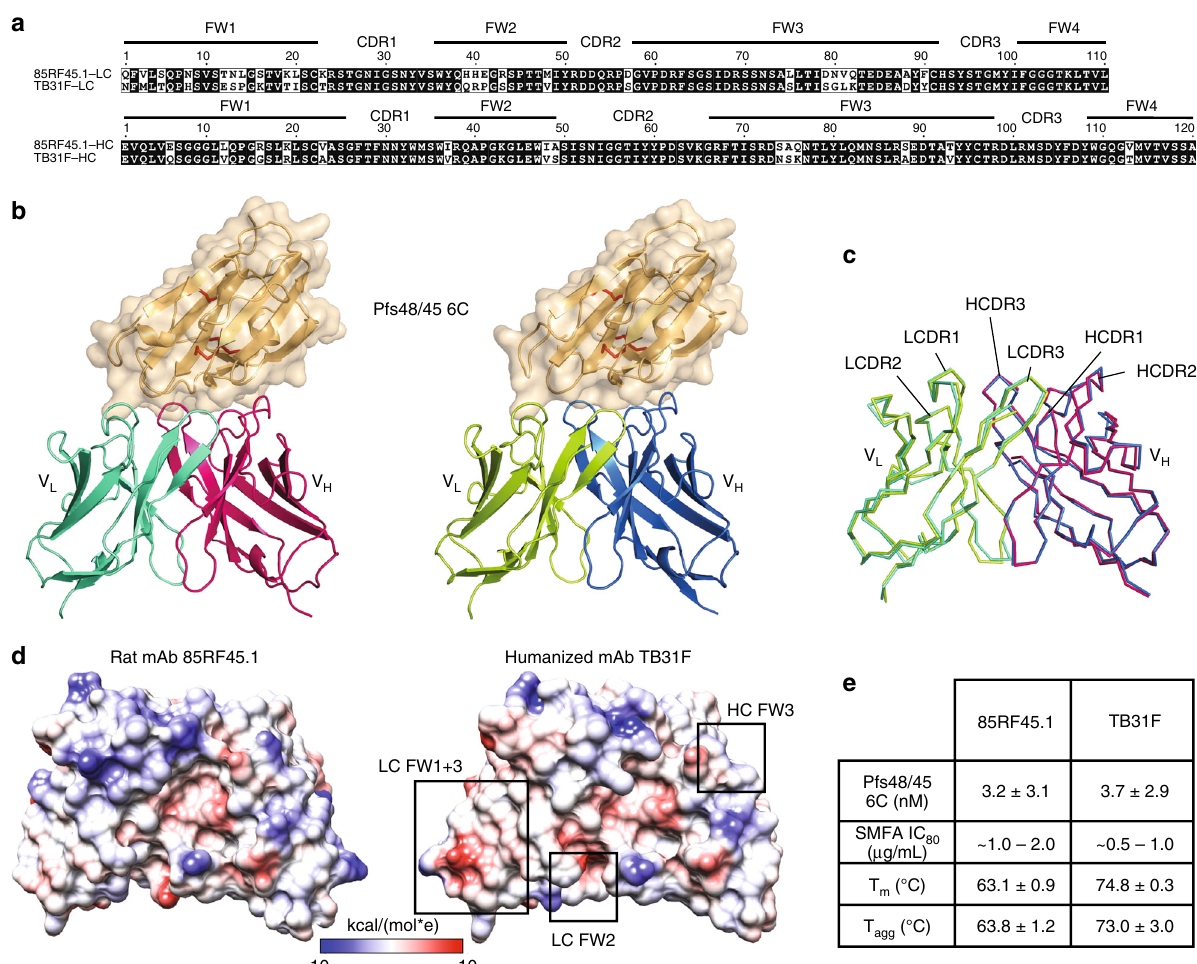
Fig. 5 Humanization of transmission-blocking mAb 85RF45.1. a Sequence alignment between rat-derived mAb 85RF45.1 and its humanized counterpart mAb TB31F. CDRs and framework regions (FW) are de fi ned according to the Kabat convention 60 . b Comparison of the 85RF45.1Fab-Pfs48/45 6C and the TB31F Fab-Pfs48/45 6C crystal structures. Pfs48/45 is shown as an orange surface and secondary structure cartoon, whereas Fabs are represented as secondary structure cartoons. Only the Fab variable region is shown for clarity. c Superposition of the variable regions of the unliganded 85RF45.1 Fab (teal and magenta) and the unliganded TB31F Fab (green and blue) crystal structures. d Coulombic electrostatic surface coloring of the variable regions of